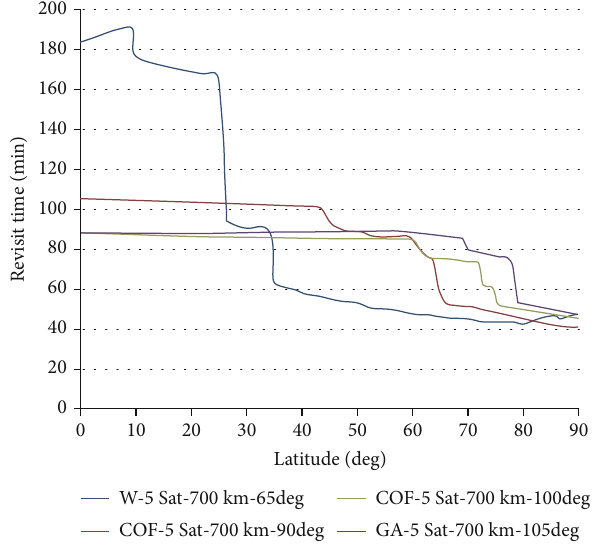
Figure 16: MRT variations for 5 satellite